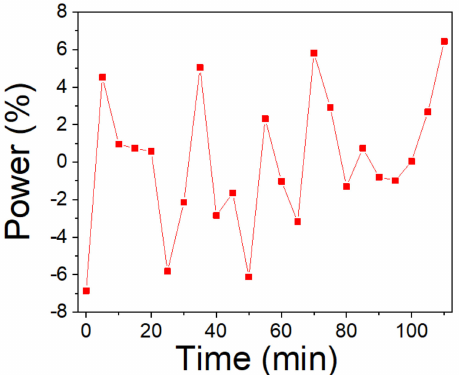
Figure 6. Measurement of output power